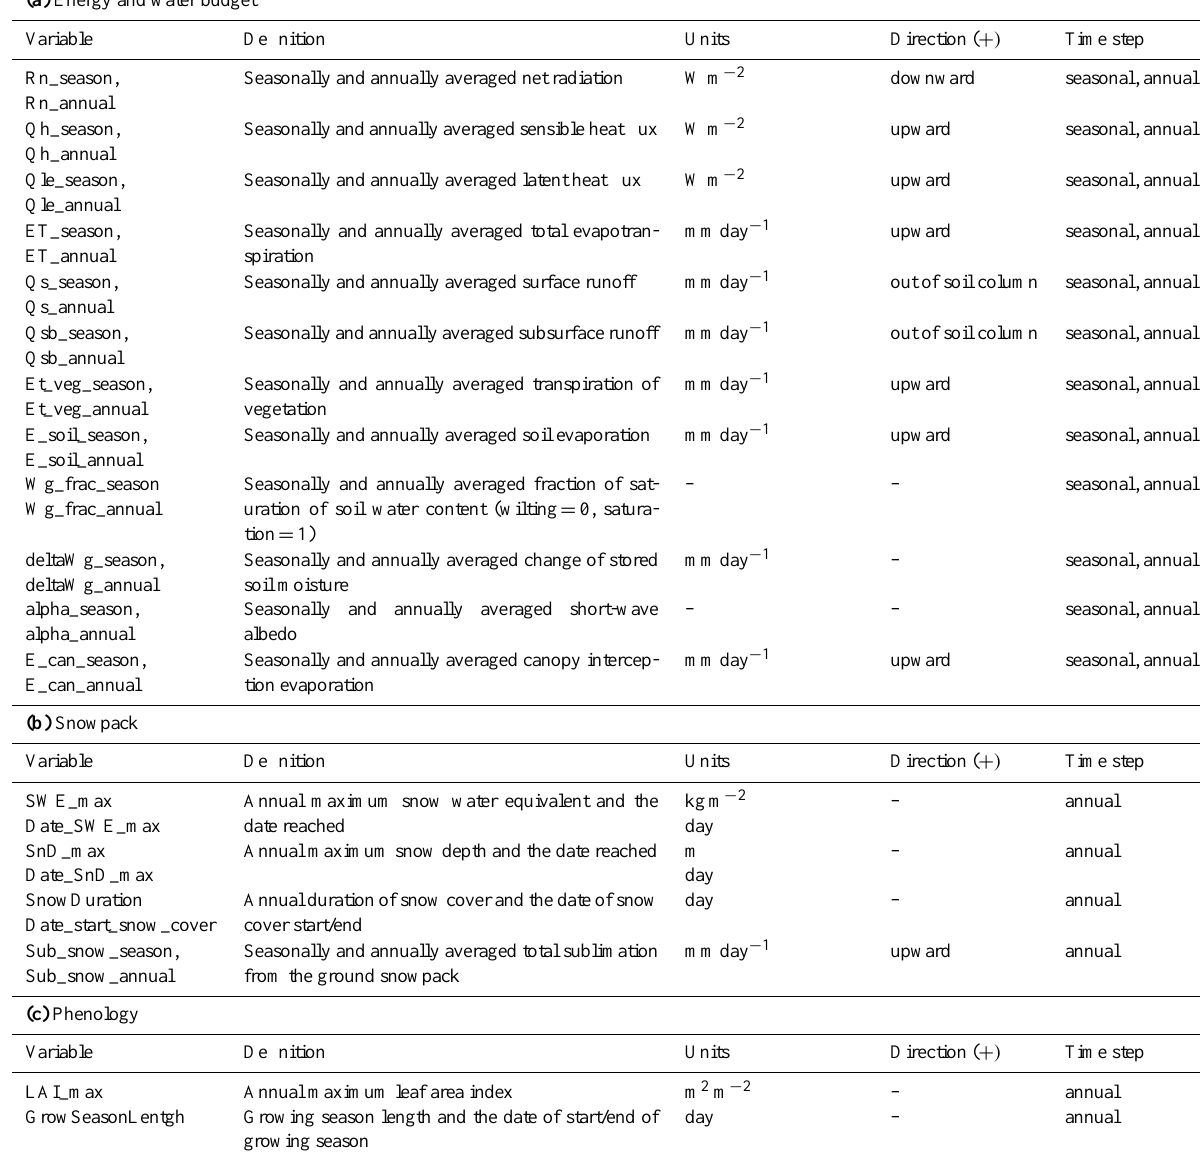
Table 3. The list of metrics for model performance evaluation for (a) energy and water budgets, (b) snowpack, (c) phenology, (d) subsurface hydrological and thermal states, and (e) the carbon